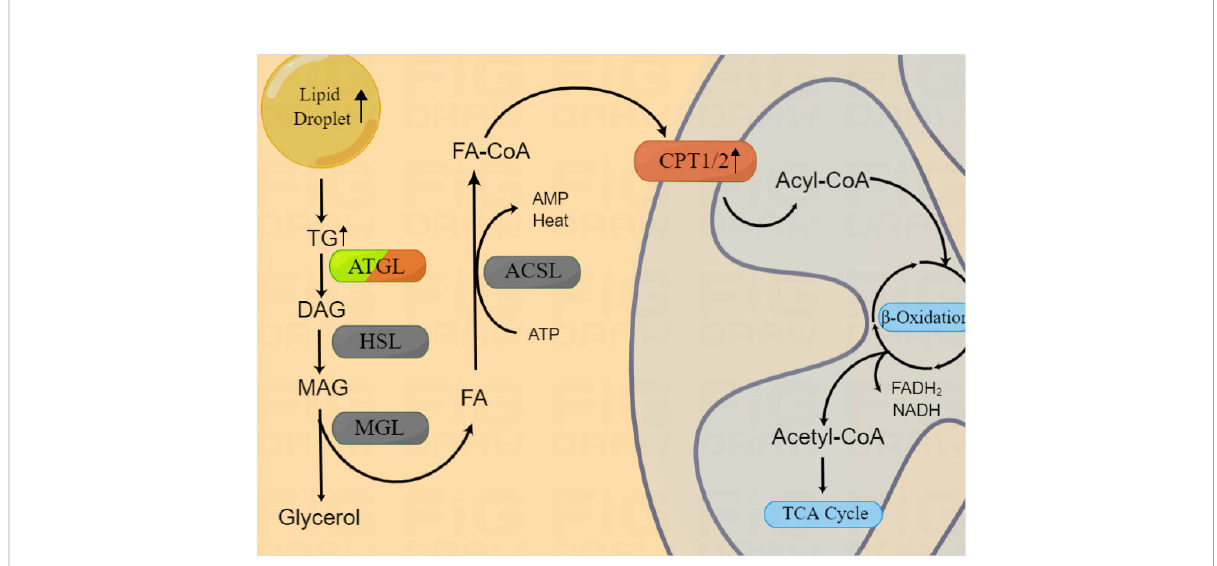
FIGURE 2 Lipid catabolism in HNSCCs. Enzymes involved in lipid catabolism are shown in the fi gure. After release from the LD, triacylglycerol is broken into FA-CoA by lipolysis-related enzymes and catabolized by FAO to produce energy and substrates for the mitochondrial TCA cycle. b - oxidization are reported to be upregulated in HNSCCs, however, the expression of ATGL in HNSCCs is still